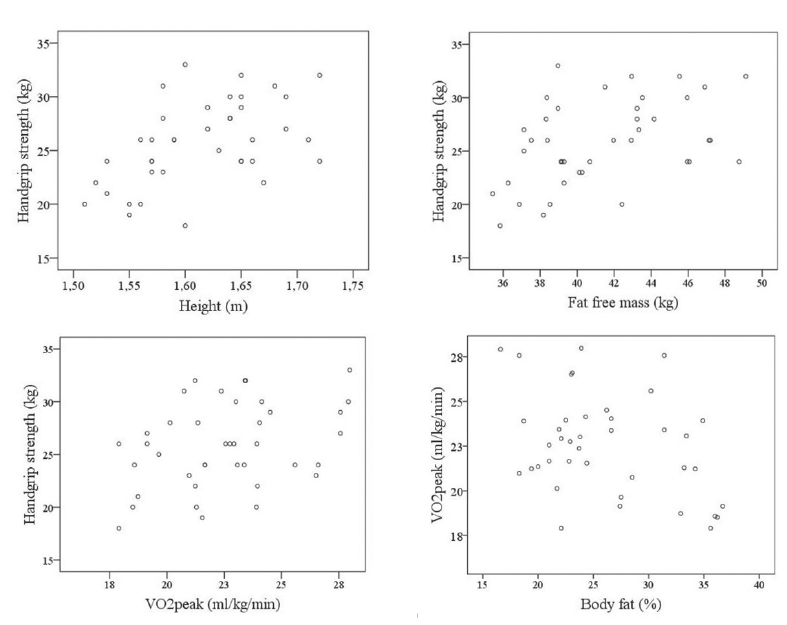
FIGURE 2. Scatterplots of correlation analysis of assessed parameters. VO2peak- peak oxygen